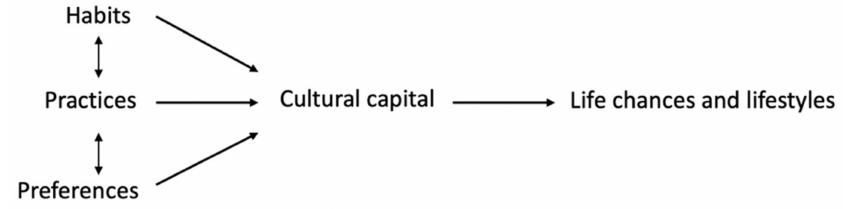
Figure 8. Cultural capital